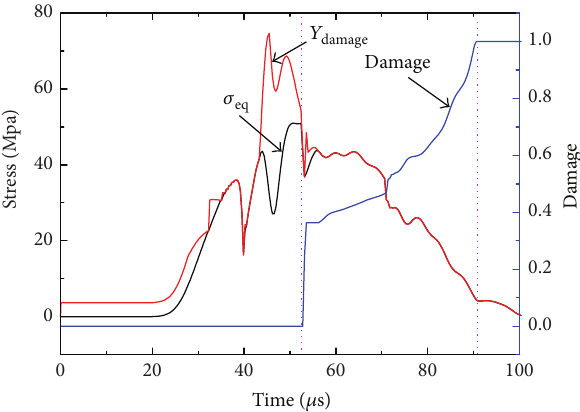
Figure 5: Equivalent stress, failure stress, and damage versus time of target